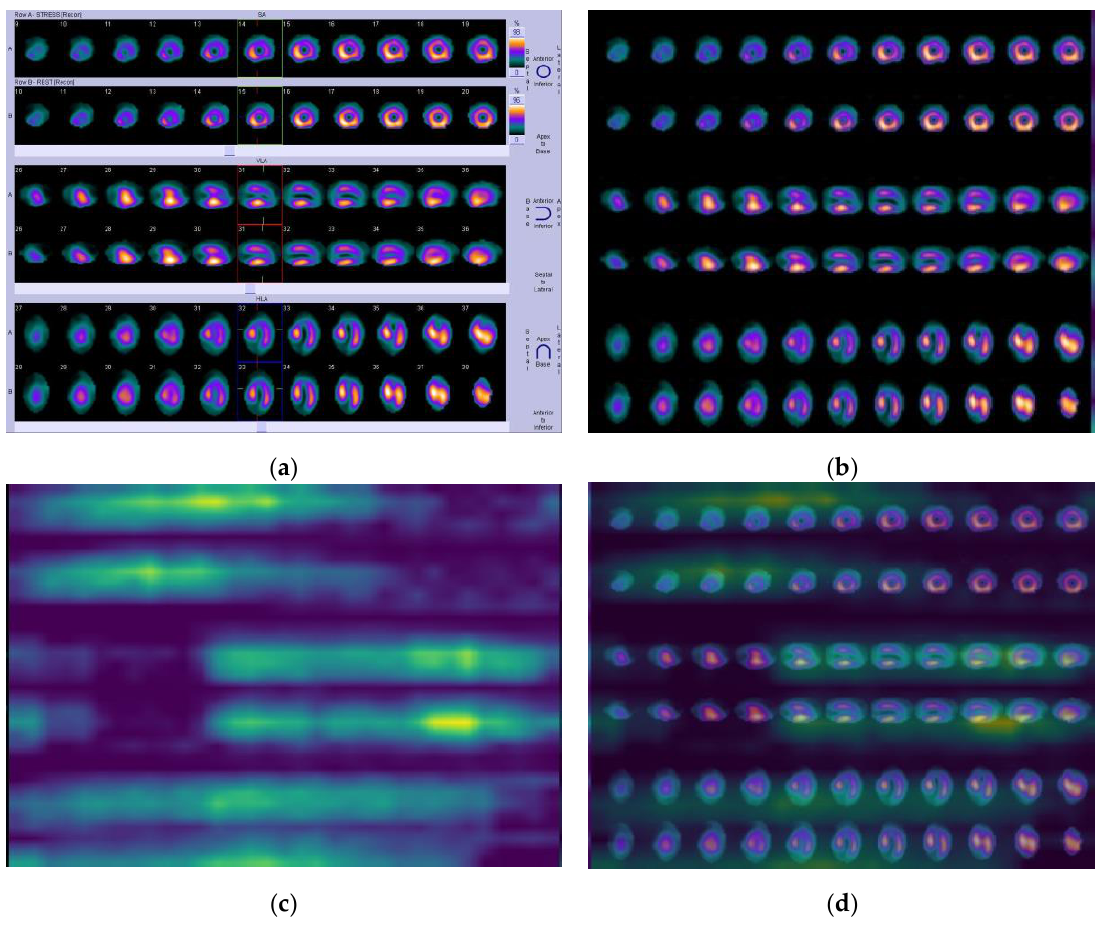
Figure 5. Case A. ( a ) Initial SPECT MPI image; ( b ) processed image; ( c ) produced heatmap; and ( d ) visualized image generated by Grad-CAM for infarction.